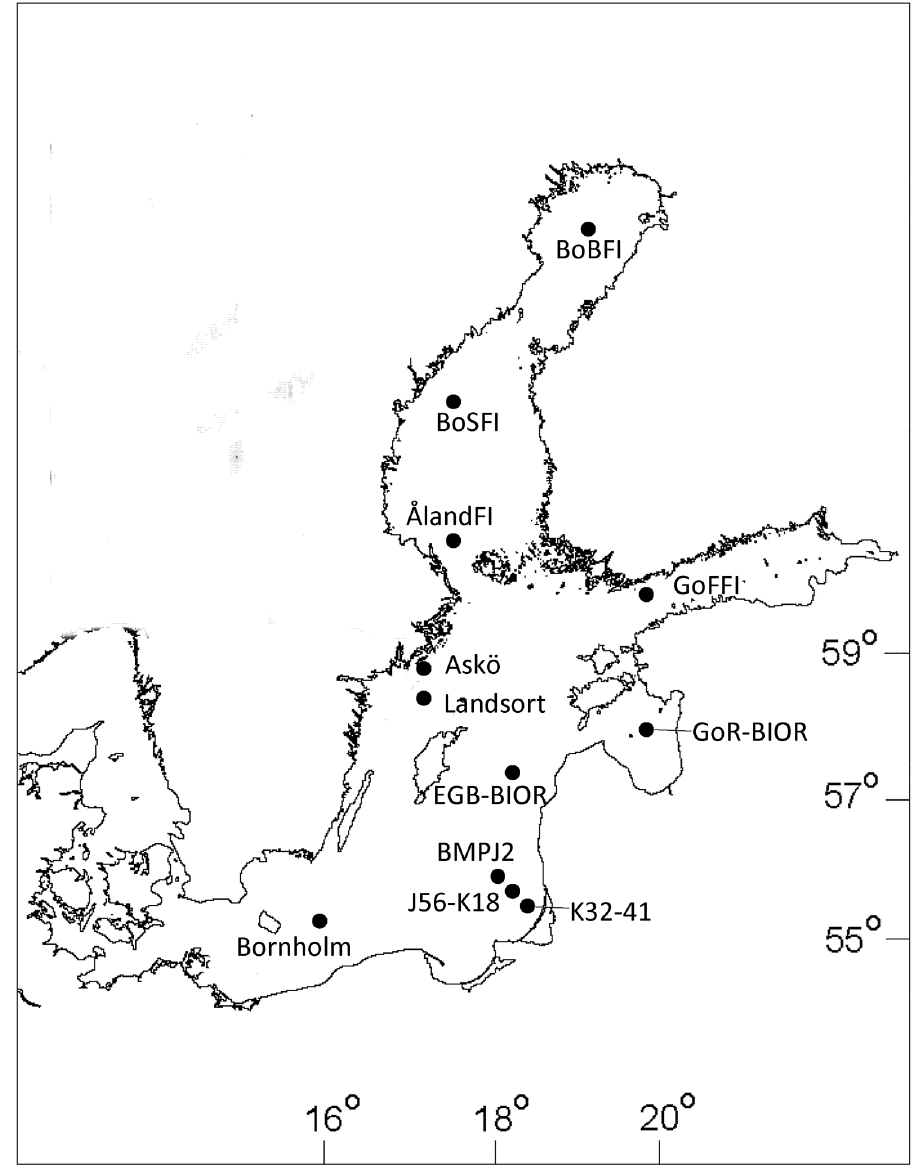
Fig 1. Map of the Baltic Sea indicating sampling sites for zooplankton datasets used in this study. Each dataset is represented by a single circle; when several stations contributed to a dataset, the circle shows the approximate middle of the sampled area. See Table 1 for description of sampling sites and sampling